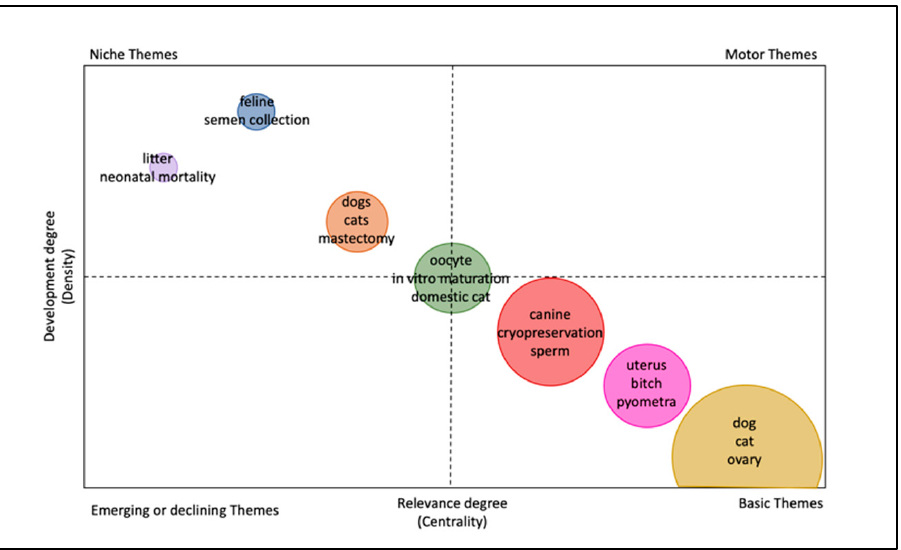
Figure 6. Thematic map showing relevance and development of topics in small animal reproduction.